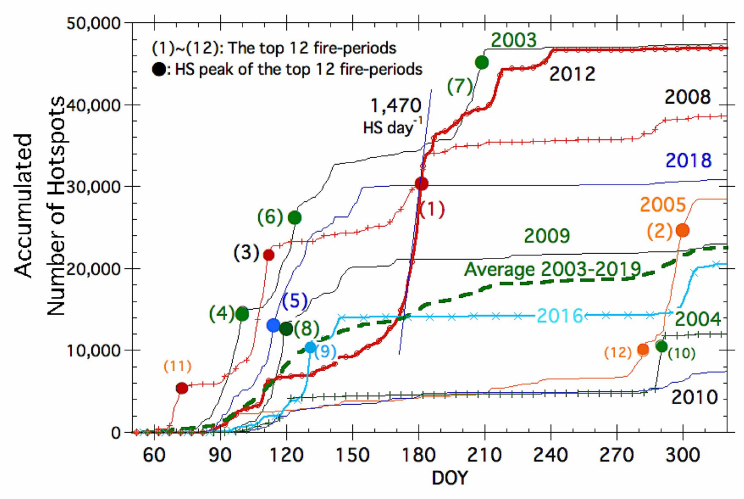
Figure 3. Accumulated number of hotspots (HSs) for nine